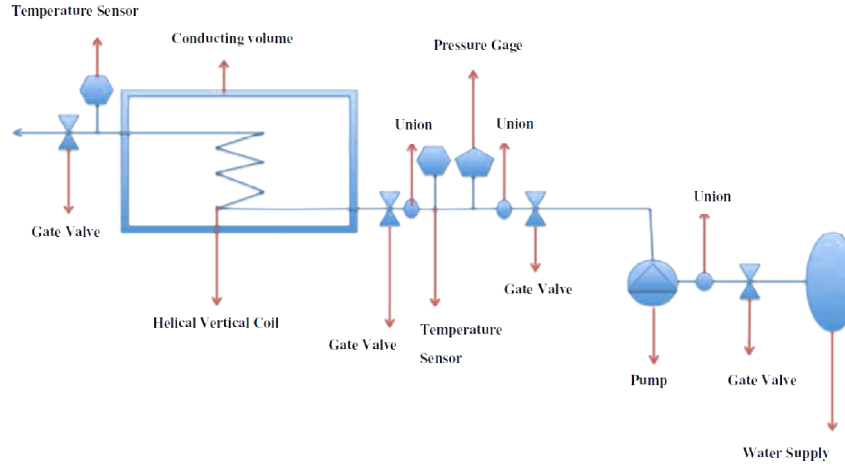
Figure 2. Experiment